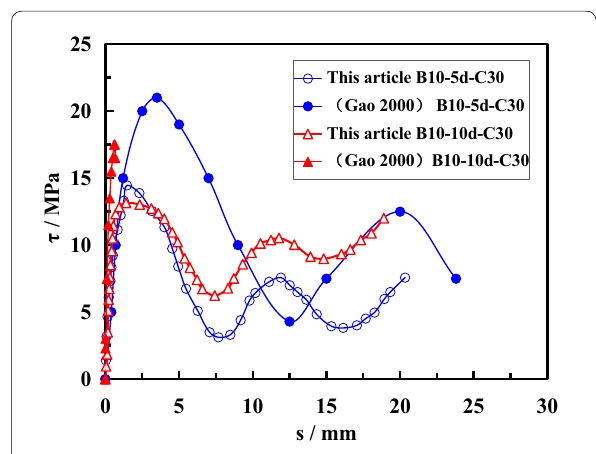
Fig. 12 τ - s curves of BFRP rebar—coral concrete or common